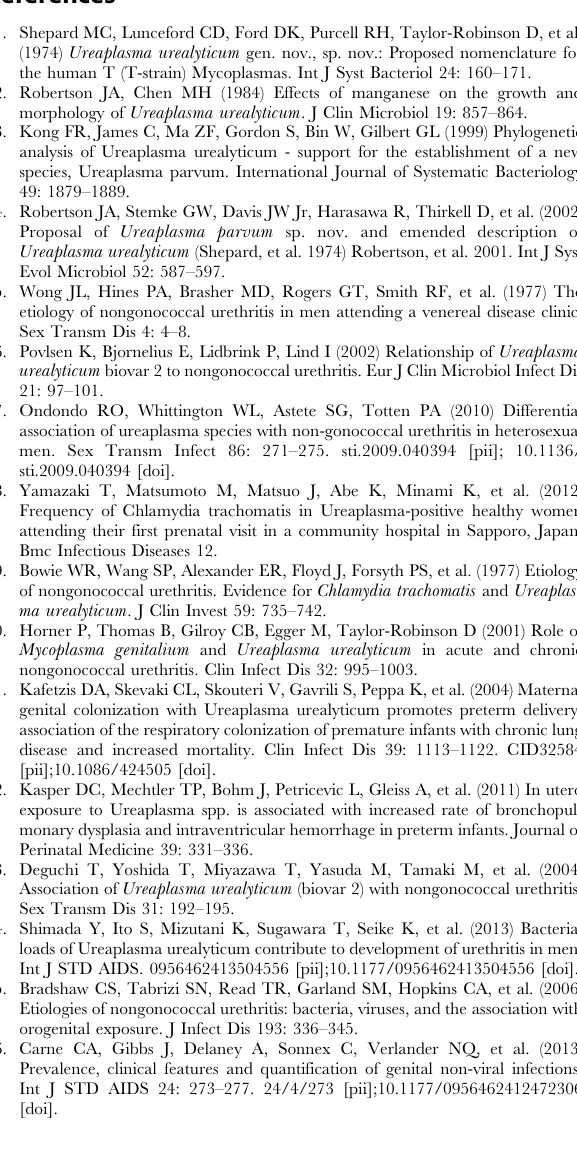
Table S1 Result of re-testing 12 original samples with discrepant culture and qPCR results and the matching urine samples. Results are given as colour-changing units (CCU) and as DNA copies/200 m l of the transport medium to adjust for differences in the amount of template or